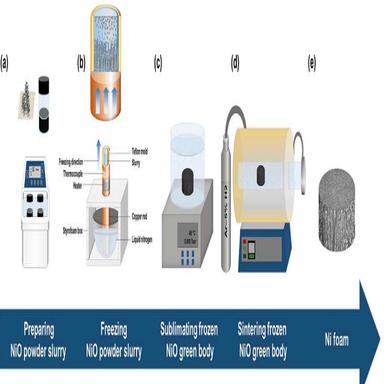
Schematic diagram of the Ni foam production sequence: (a) preparation of NiO slurry, (b) freeze casting of the NiO slurry, (c) sublimation and drying, (d) sintering and reduction of NiO green boddy, and (e) final Ni foam. (For interpretation of the references to color in this figure legend, the reader is referred to the Web version of this article.)